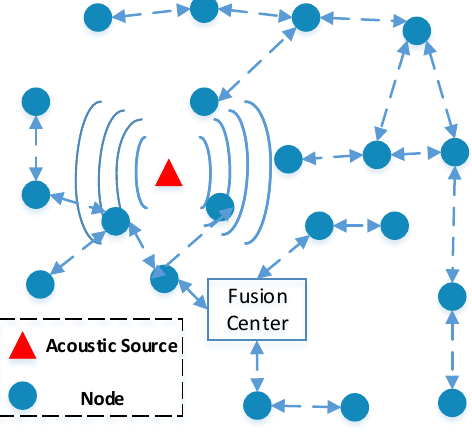
Figure 1. Acoustic nodes (filled circles) receive signal generated by an acoustic source (represented by a filled triangle) and data fusion for source